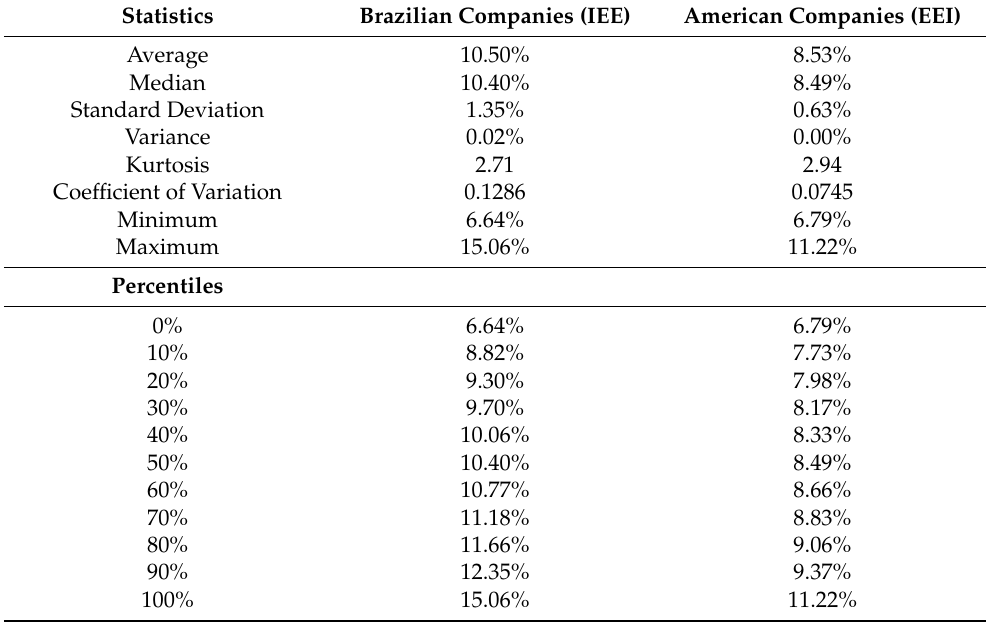
Table 5. Descriptive statistics of the output variables of the WACC projection from the perspective of IEE and EEI